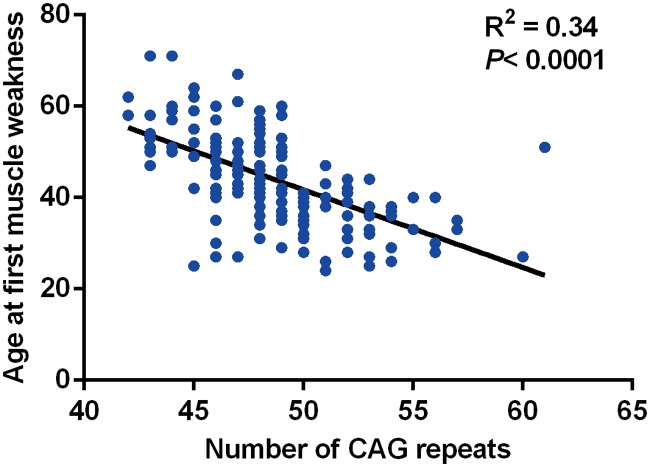
Relationship between the number of CAG repeats and the age at first muscle weakness.There is an inverse relationship between the number of CAG repeats and the age at first muscle weakness (R2 = 0.34, p<0.0001).